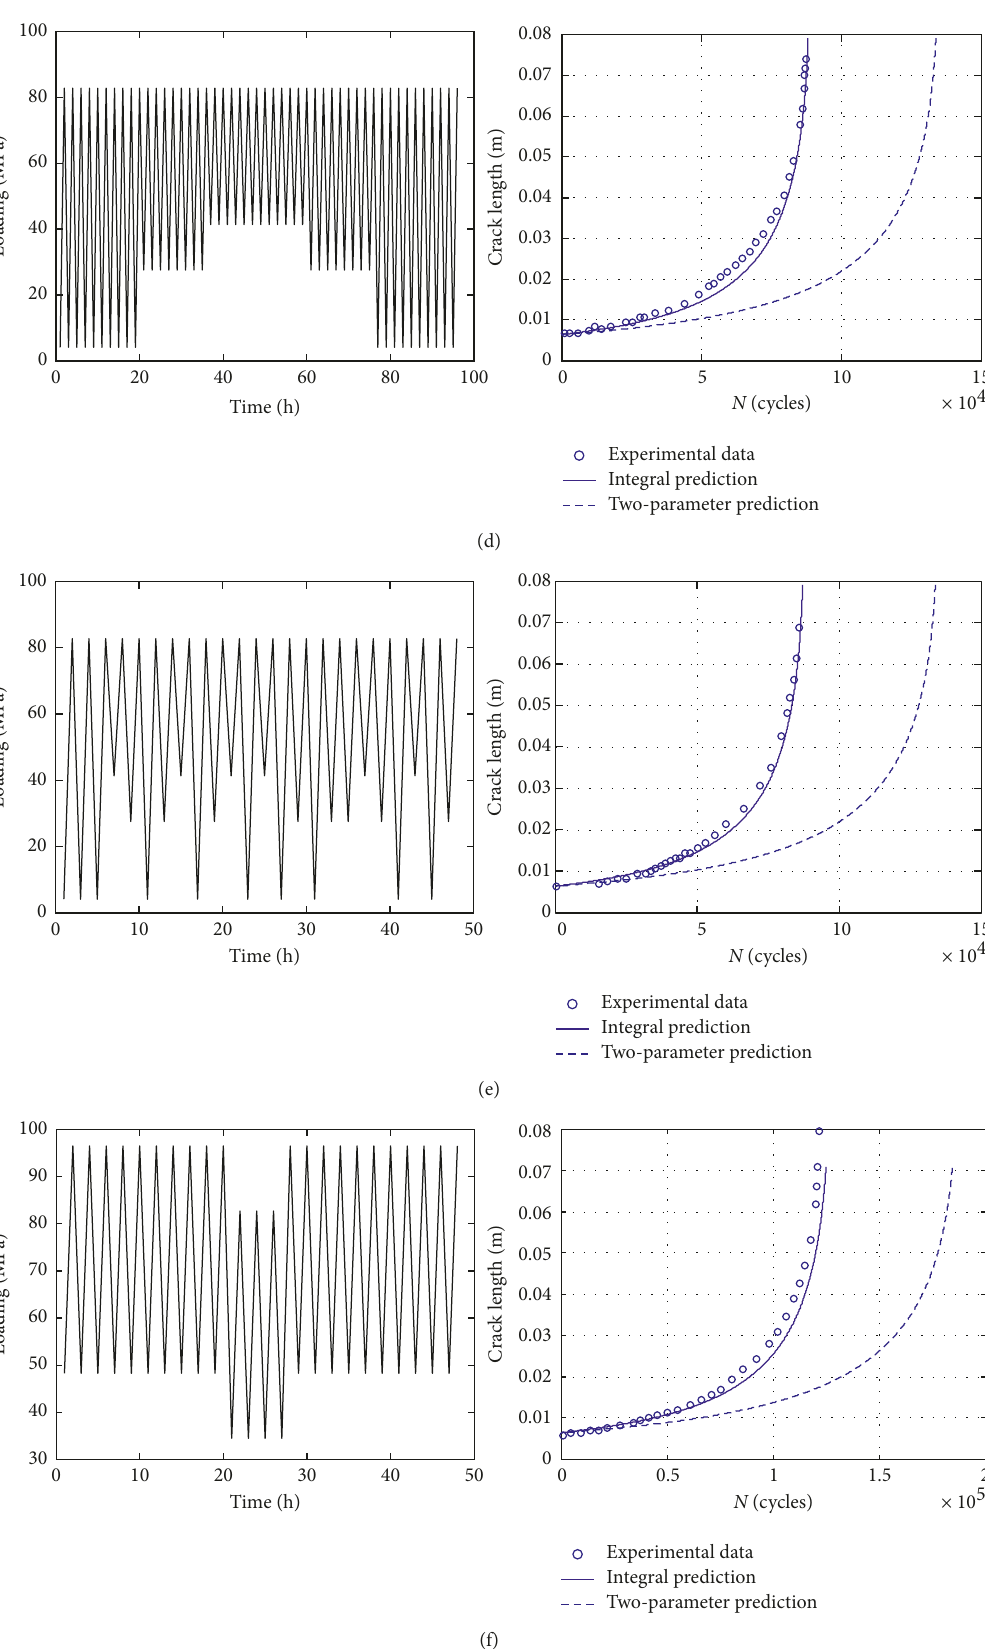
Figure 10: a - N curves under VA loading. (a) Spectrum 1, (b) spectrum 2, (c) spectrum 3, (d) spectrum 4, (e) spectrum 5, and (f) spectrum